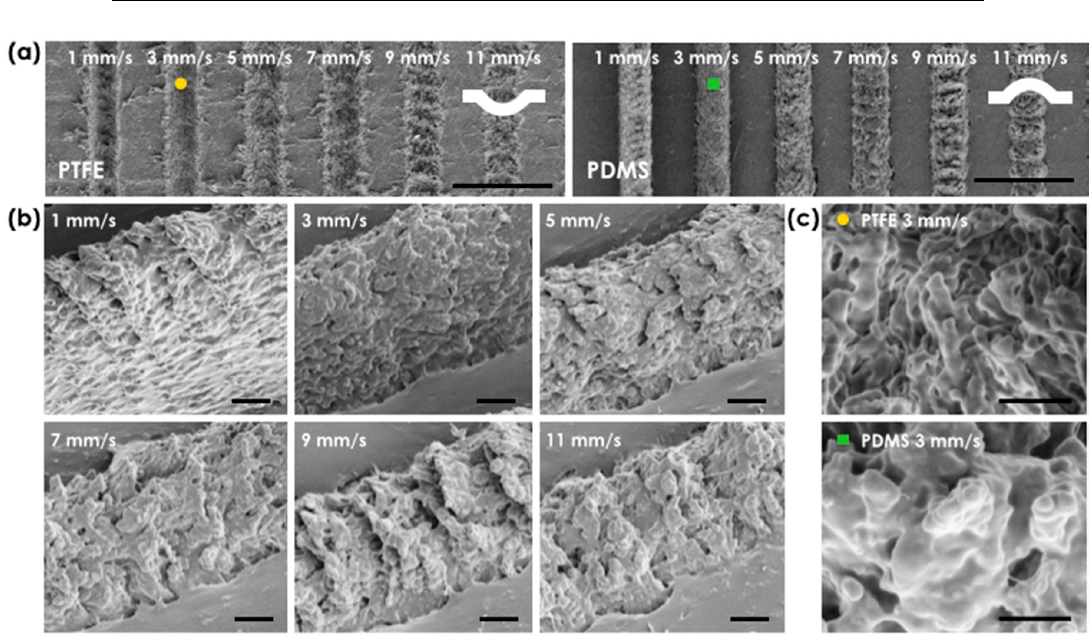
Figure 2. Line ablation with rough surface on a PTFE film by sample scanning: ( a ) SEM pictures of ablated PTFE film at the laser fluence of 56 J/cm 2 and varied sample scanning speeds from 1 to 11 mm/s, and PDMS replica from the PTFE film. The scale bars are 50 μ m. The white curved lines illustrate the surface profiles of PTFE and PDMS films; ( b ) Tilted SEM pictures of the PDMS replica. The scanning speed affects the height of PDMS replica (or the depth of PTFE template). The scale bars are 5 μ m; ( c ) Magnified SEM pictures of rough PTFE and PDMS region (marking with circle and box in ( a )) at the scanning speed of 3 mm/s. The scale bars are 2 μ m.